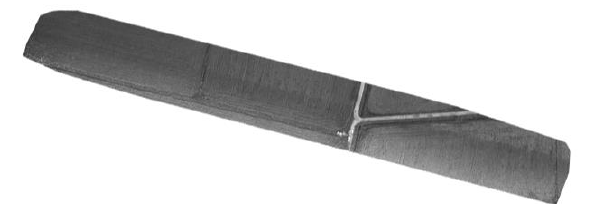
Figure 13. Skeleton structure for Block 3 obtained by point cloud